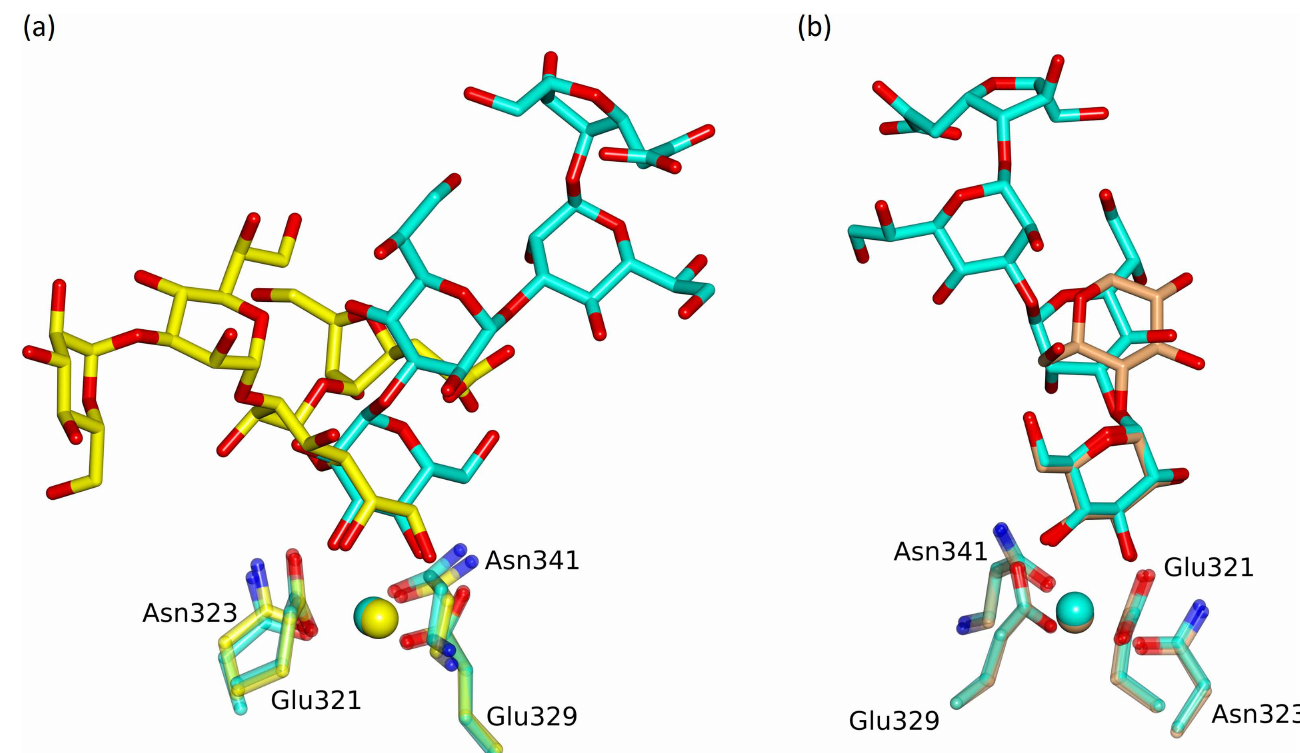
Fig 7. (a) Superposition of subunit A (GlcI bound) in cyan and subunit B (HepI bound) in yellow of the R5 LPS-bound structure following a least-squares fit of the CRD protein main chain atoms. (b) Superposition of subunit A (GlcI bound) in cyan of the R5 LPS-bound structure and subunit A (Glc1 bound) in coral